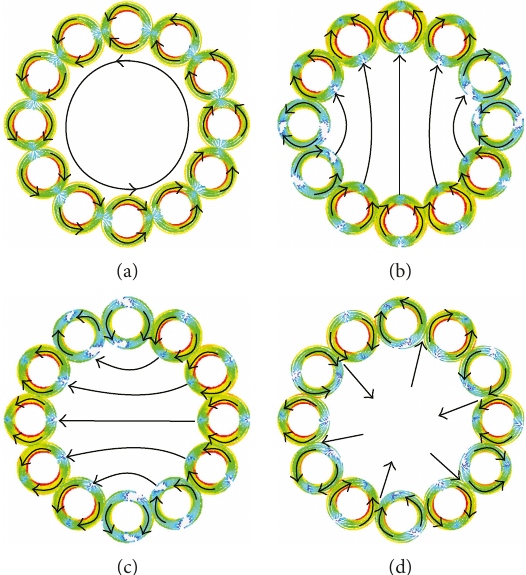
Figure 4: Modal currents of the proposed lens on the XY plane at 10GHz: (a) mode 1, (b) mode 2, (c) mode 3, and (d) mode 4.